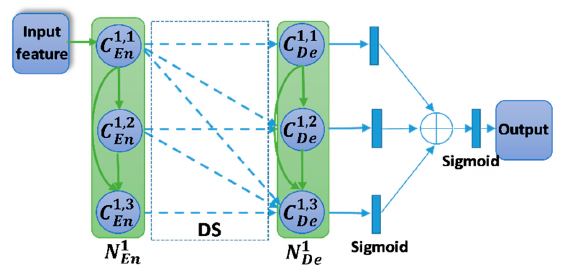
Figure 4. The dense skip connection between the encoder node and decoder node. The blue dashed arrow denotes the skip connection. Symbol ⊕ indicates the concatenation operator.